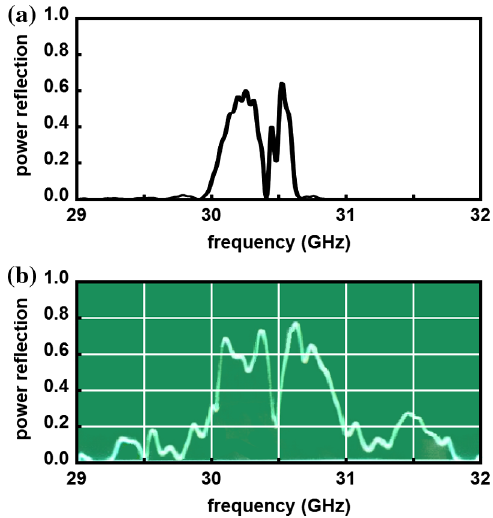
FIG. 8. A photograph of the microwave system of a coaxial Ka-band BWO: (a) inner and (b) outer conductors: (1) 2D Bragg structure, (2) regular waveguide section, (3) slow-wave structure, and (4) output horn.